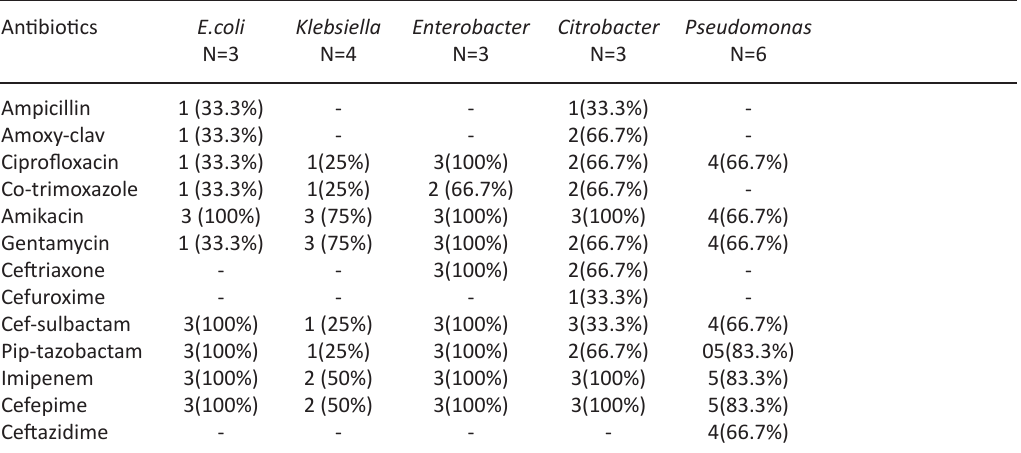
Table 4. Antibiotic susceptibility of Gram negative bacteria [number(%) of sensitive strain]